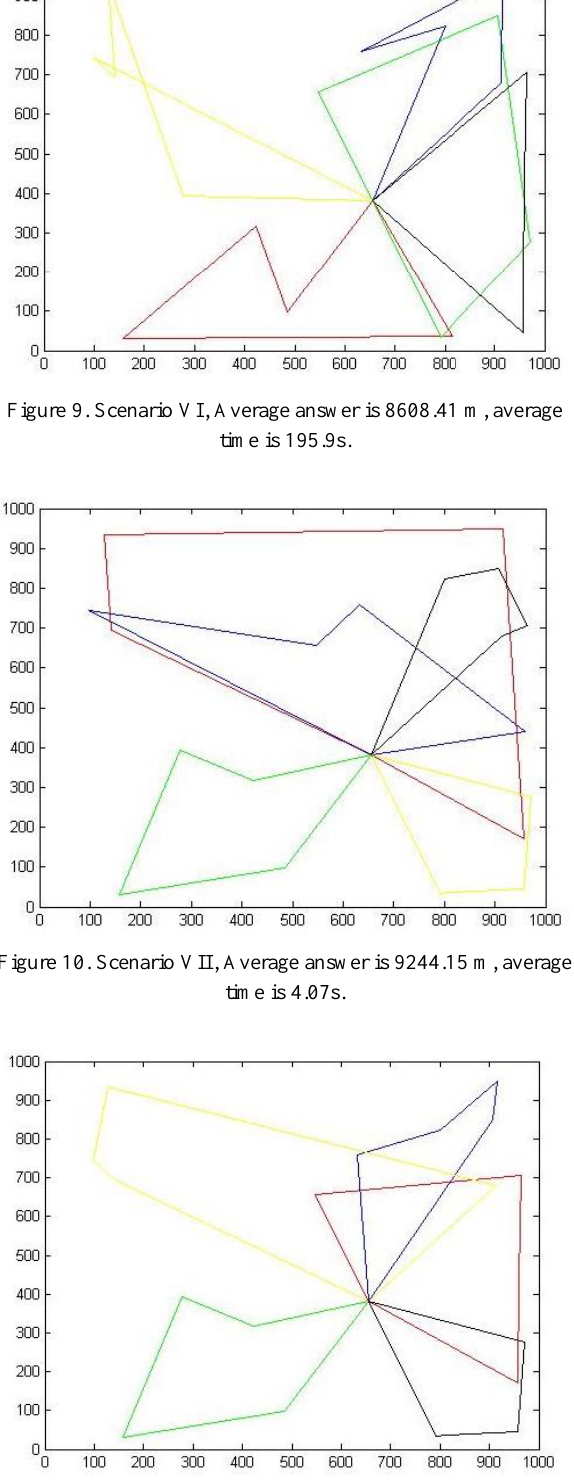
Figure 11. Scenario VIII, Average answer is 8657.8 m, average time is 615.28